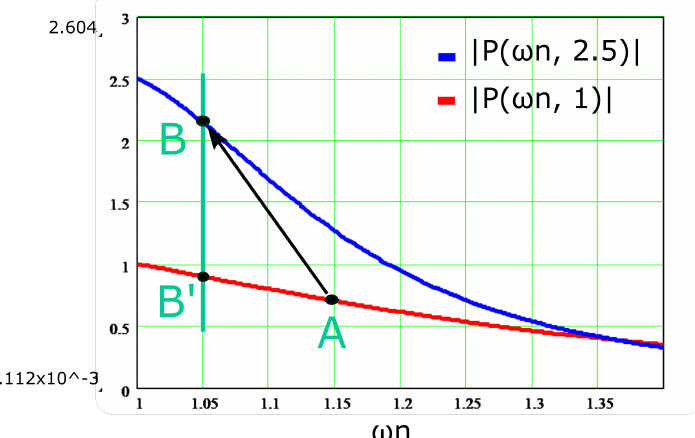
Figure 5. Output power